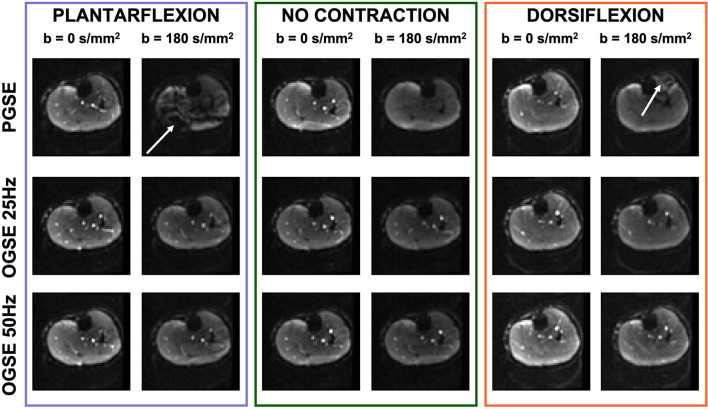
Non-diffusion-weighted and diffusion-weighted scans of one volunteer acquired during active plantarflexion (purple), with relaxed musculature (no contraction, green), and during active dorsiflexion (orange). The pulsed gradient spin echo (PGSE) scans show localized areas of signal voids (white arrow) originating by spin dephasing during muscle activation. Note the bright signal from blood vessels in the diffusion-weighted scans obtained with oscillating gradient spin echo (OGSE), indicating motion compensation.